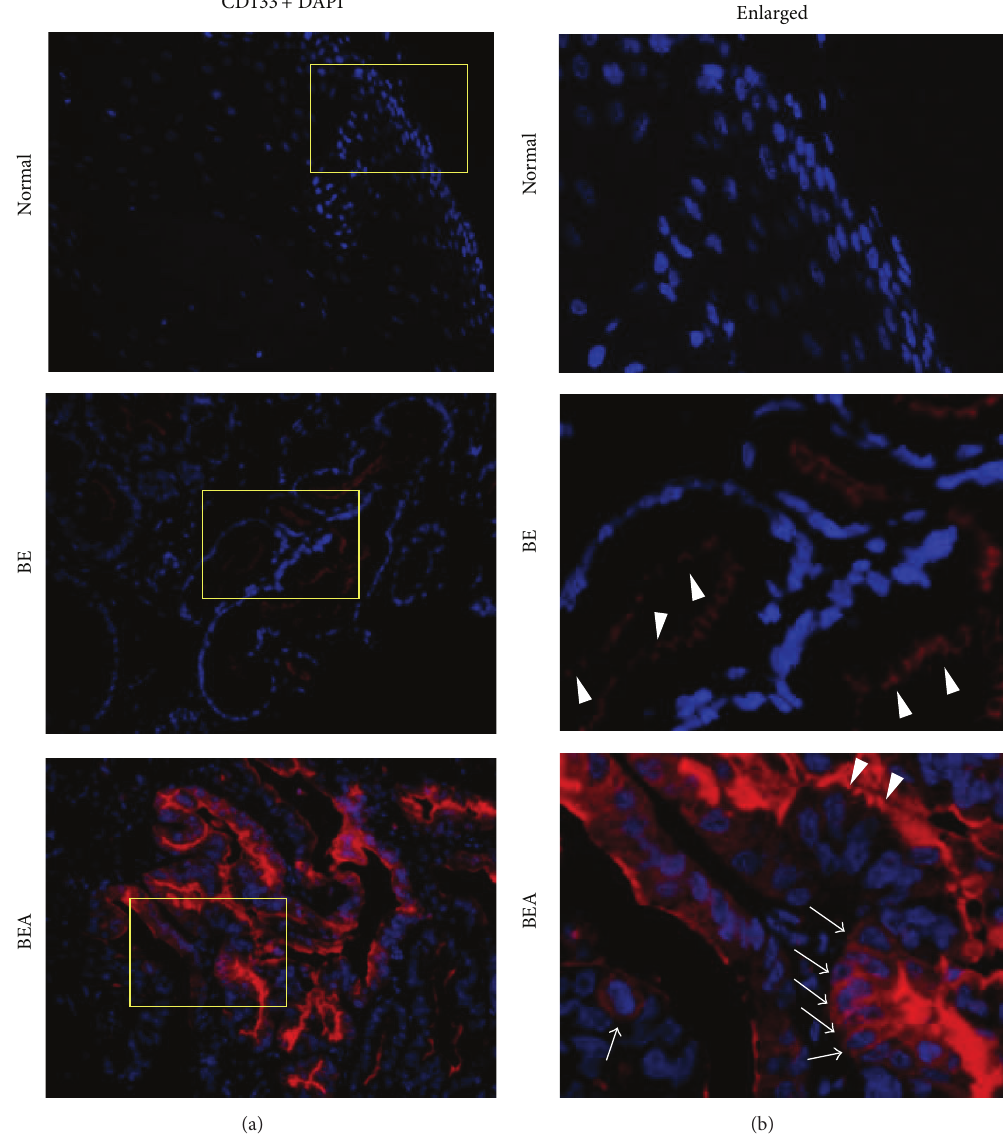
Figure 1: CD133 expression in normal esophageal (Normal), Barrett’s esophagus (BE), and Barrett’s adenocarcinoma (BEA) tissues. CD133 expression (red) was examined by immunofluorescence technique. DAPI (blue) was used for nucleic counterstaining. The original magnification is × 200 (a). (b) represent enlarged pictures of the yellow boxes in (a). Arrowheads indicate CD133 expression at apical surface. Arrows indicate cell membrane and cytoplasmic CD133